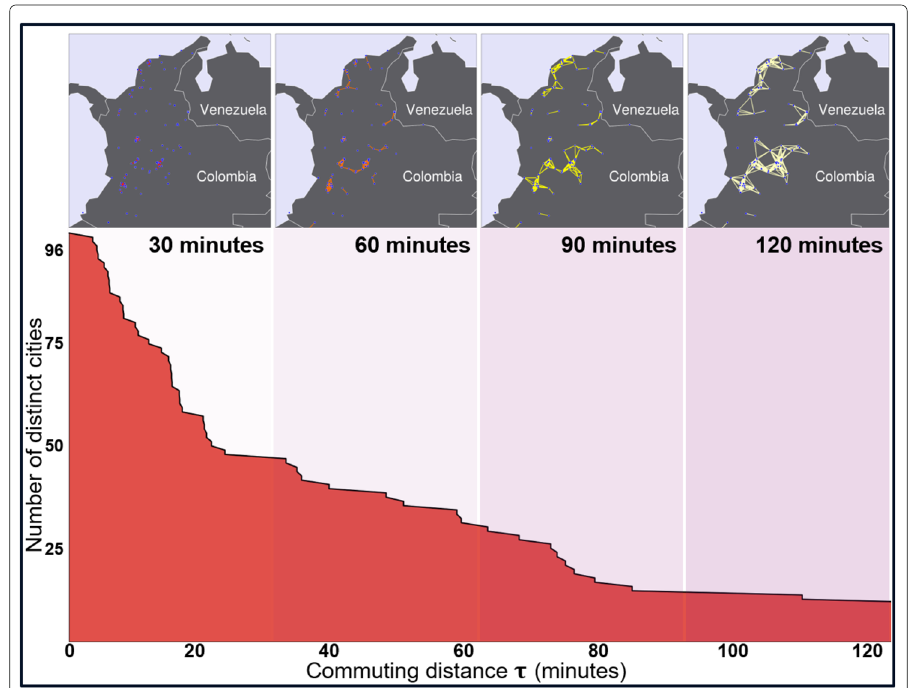
Fig. 2 The four maps show the connected components of the municipality commuting network when considering a threshold τ = 30, 60, 90 and 120 minutes respectively, which represent the commuting time between connected municipalities. As τ increases, and municipalities are connected within new city definitions, the number of cities